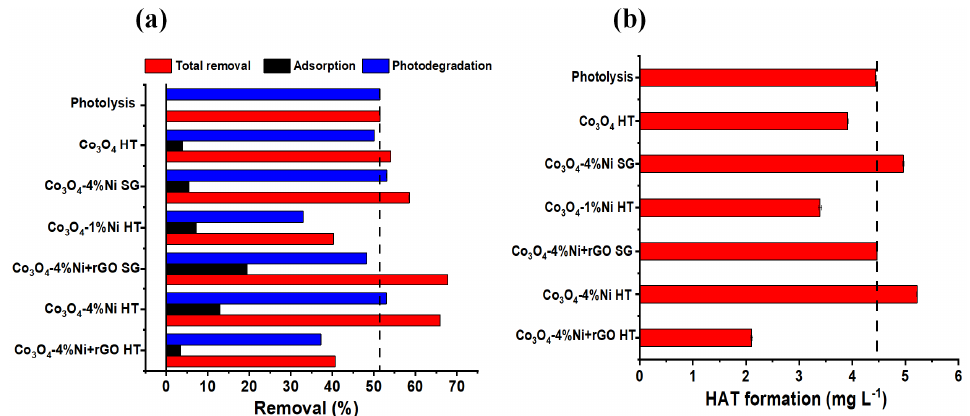
Figure 8. ATZ removal by adsorption, photocatalysis, total (adsorption + photocatalysis) ( a ) and HAT formation ( b ) in 30 min for the samples, at 400 °C; Co 3 O 4 HT, Co 3 O 4 -4%Ni SG, Co 3 O 4 -1%Ni HAT formation ( b ) in 30 min for the samples, at 400 ◦ C; Co 3 O 4 HT, Co 3 O 4 -4%Ni SG, Co 3 O 4 -1%Ni HT, Co 3 O 4 -4%Ni+rGO SG, Co 3 O 4 -4%Ni HT, and Co 3 O 4 -4%Ni+rGO HT. HT, Co 3 O 4 -4%Ni+rGO SG, Co 3 O 4 -4%Ni HT, and Co 3 O 4 -4%Ni+rGO